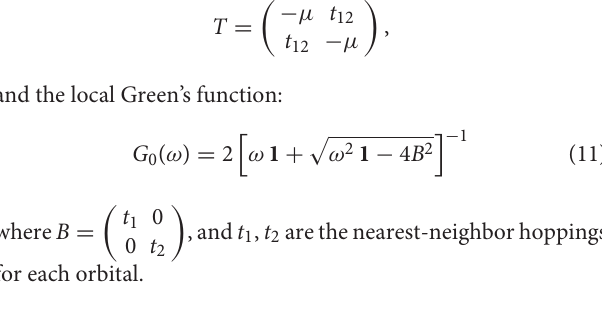
Frontiers in Physics |